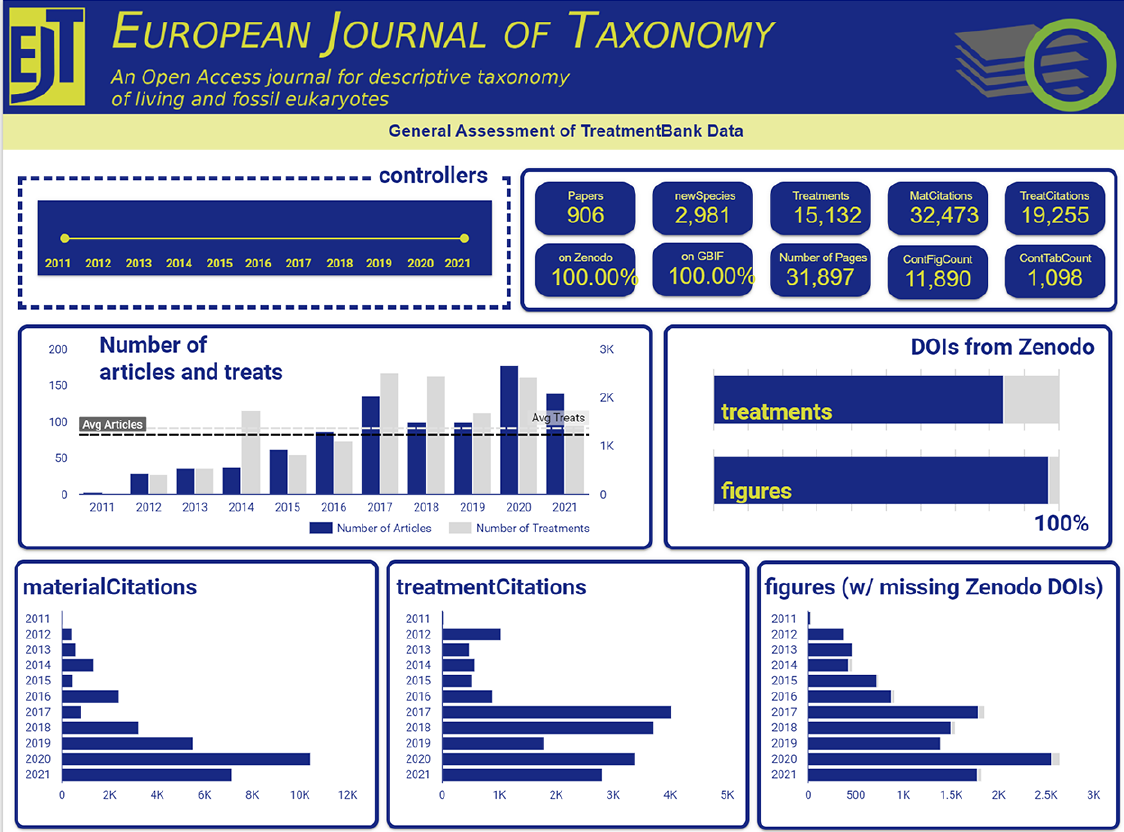
Fig. 5. Overview of EJT articles and major data liberated by Plazi and made FAIR on Biodiversity Literature Repository (source). The controllers are used to select a specific